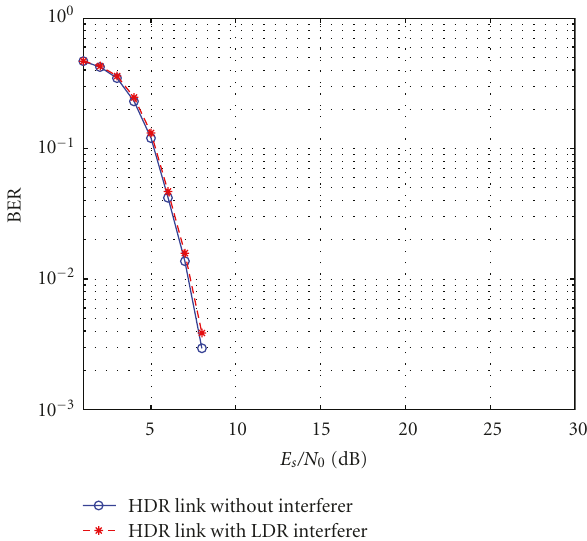
Figure 6: Interference e ff ects of an IEEE 802.15.4 interferer on an ECMA-368 link. The distance between the interferer and the intended receiver is set to 10 cm.